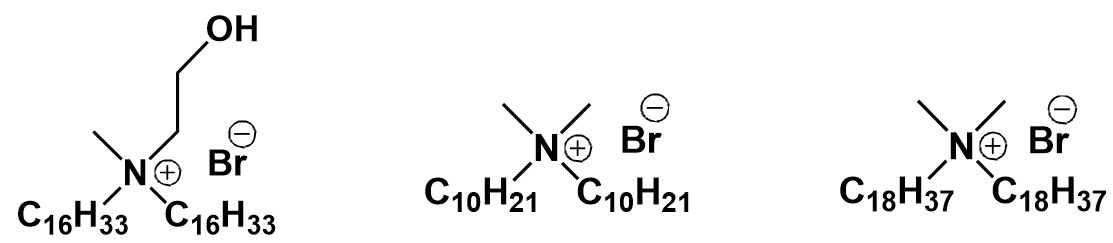
Figure 12. Structures of cationic surfactants with double, long chains.